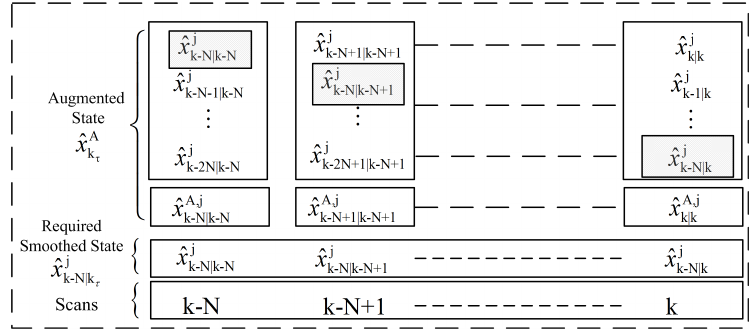
Figure 1. Smoothing window